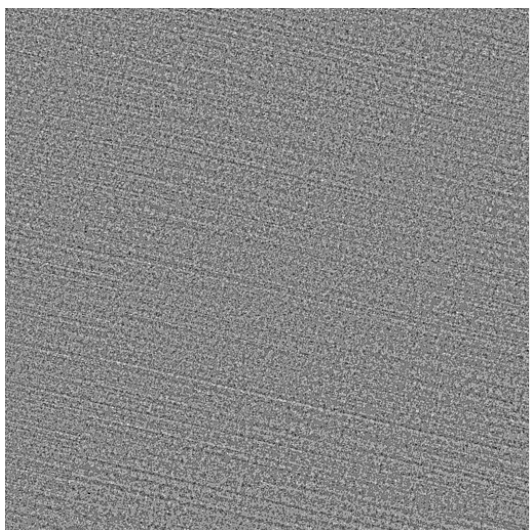
Figure 12. Magnified difference image for filtering with two nonlinearly transformed references (component images in channels ##11 and 12).